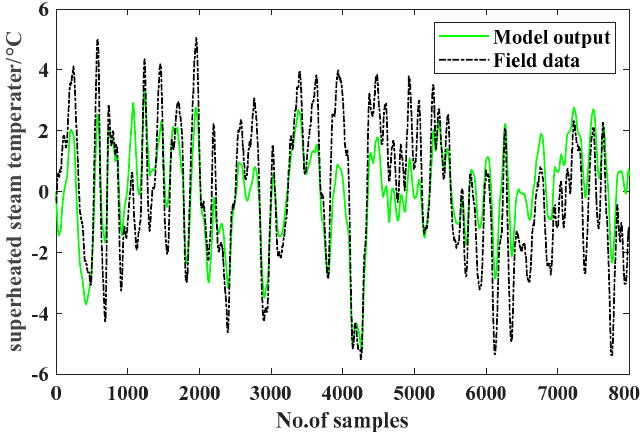
Figure 8. Output fitting of lag sector model.